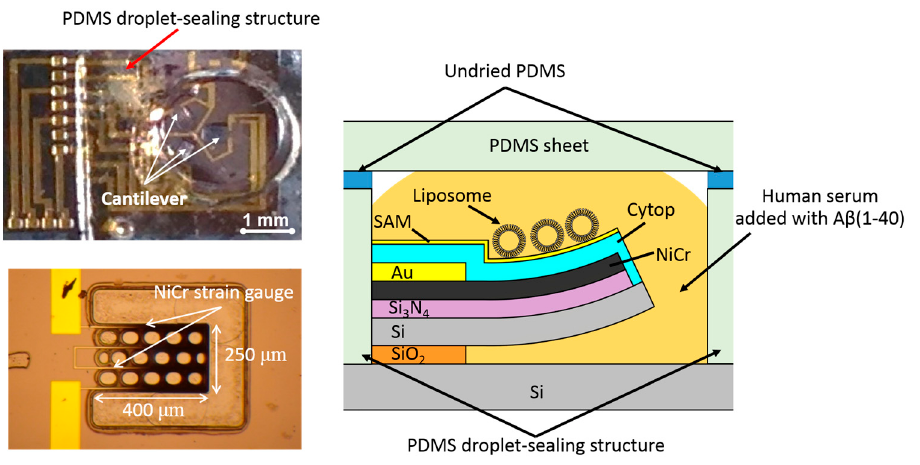
Figure 1. ( a ) Top surface; ( b ) a part of cantilever ( c ) a cross sectional illustration of the cantilever biosensor with PDMS droplet sealing structure in human serum added with A β (1-40).